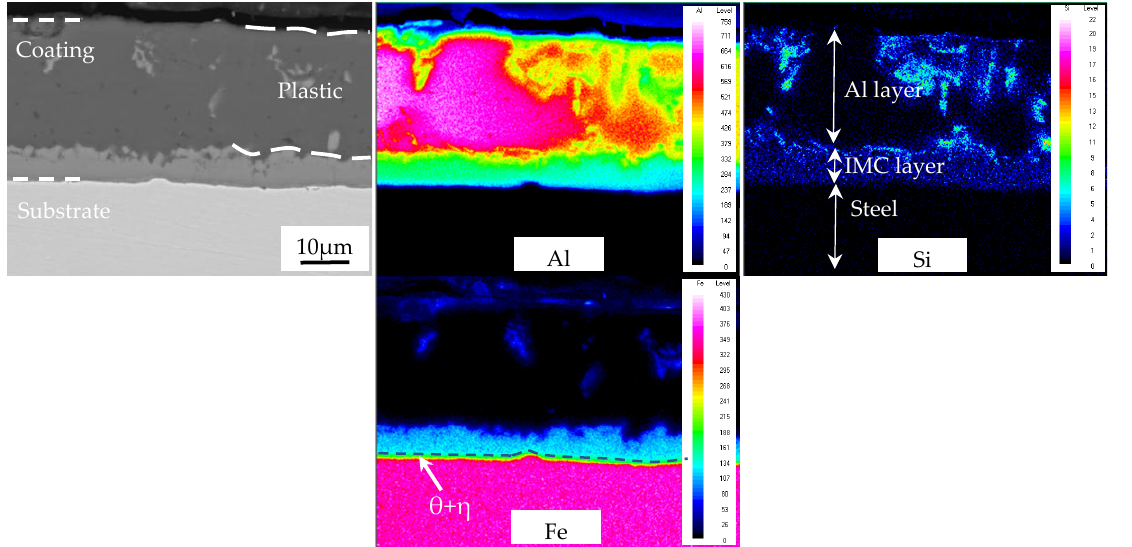
Figure 5. EDS map scan of interface between the AS60/60 coating and the steel substrate at 0% reduction ratio.